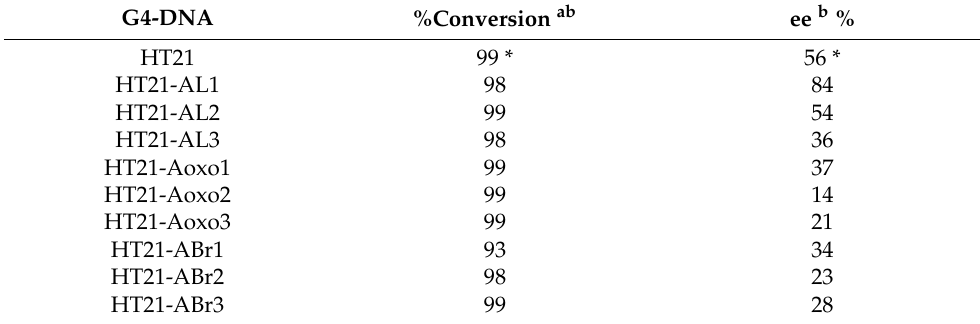
Table 2. Enantioselective oxidation of thioanisole ( 1 ). * As reported by Mingpan Cheng et al. [11]. All data are repeated for two separate experiments. a Determined by chiral-phase HPLC within reproducibility of 2%. b Determined by chiral-phase HPLC within reproducibility of 3%. HPLC chromatograms are reported in Electronic Supplementary Materials.